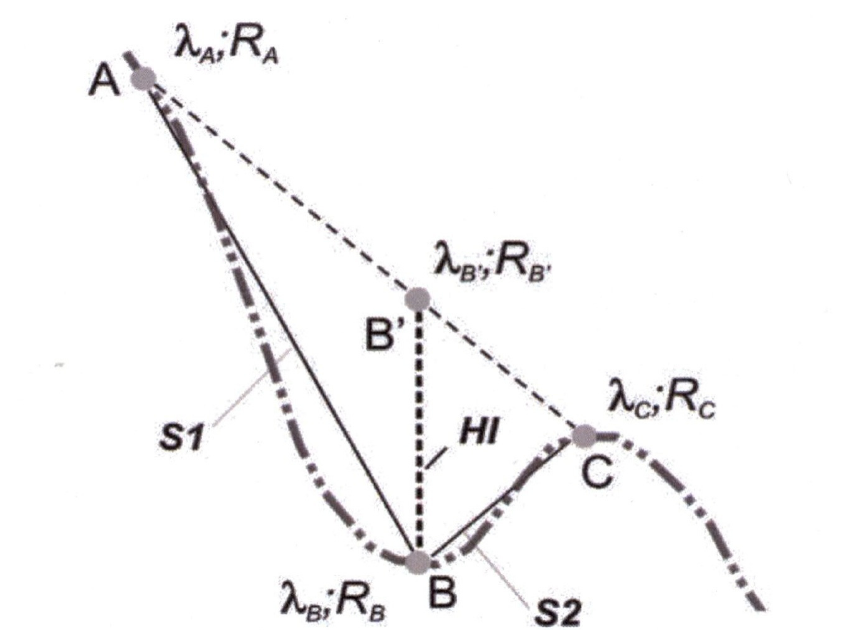
Figure 12. The graphic depiction of the hydrocarbon index based on the 1,730 nm hydrocarbon absorption feature. One of the advantages of this index is that it is valid with raw radiance data and is independent of atmospheric correction or radiative transfer functions. Source: Kuhn et al. 2004 [89].